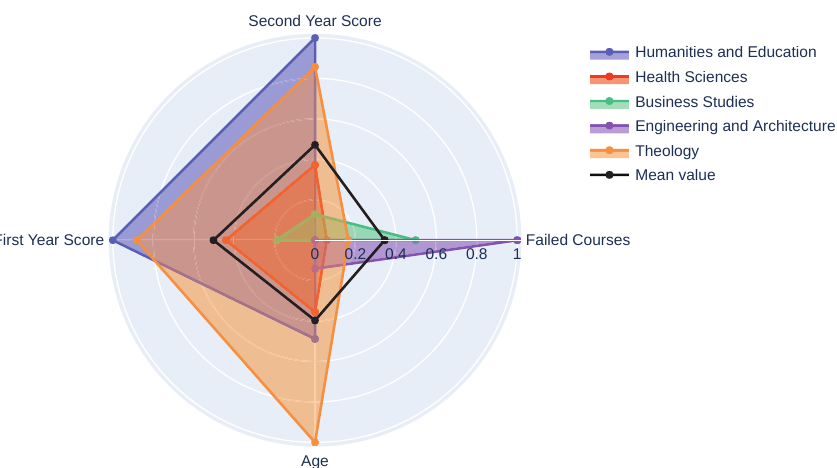
Figure 7. Principal factors by faculty. Distribution of the values of the most important attributes in the predictive model according to faculty.